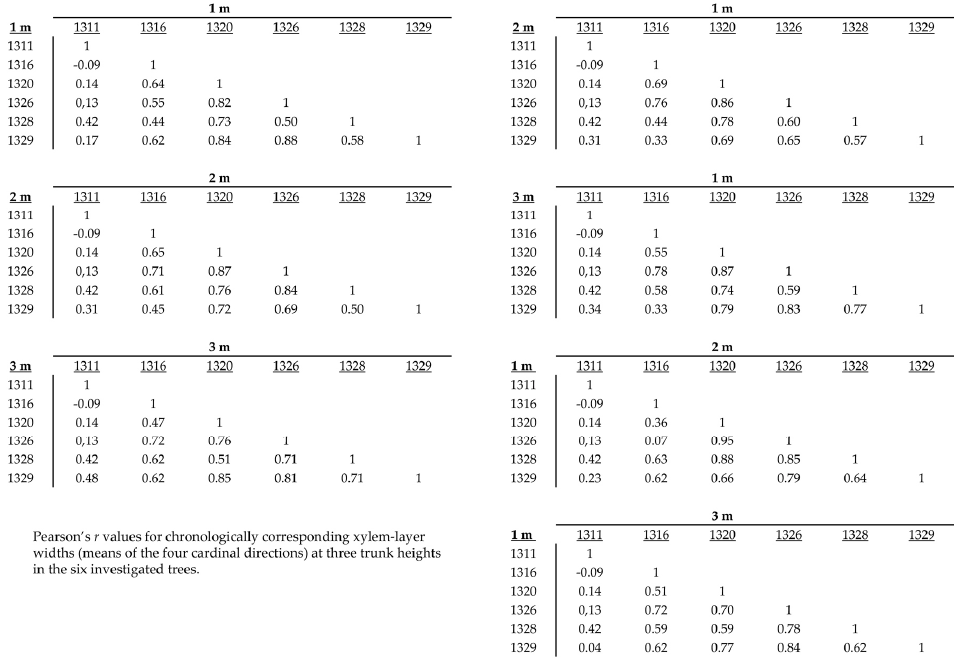
Figure 22. Between-tree correlations of gišogenetic vigour in chronologically corresponding radial series on the south side of each trunk at three trunk heights. The left panel compares tree 1311 with tree 1328, and the right panel compares tree 1320 with tree 1326.